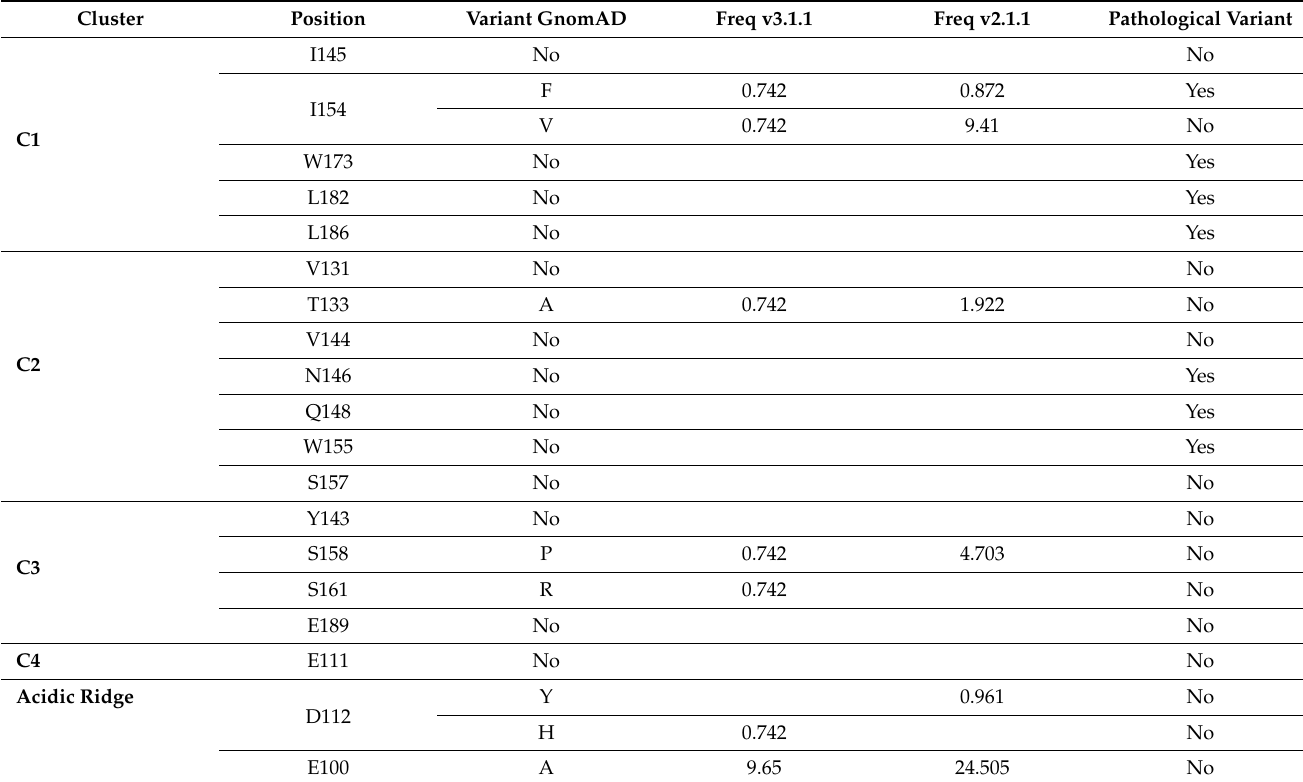
Table 2. Variants and its frequency observed in the indicated GnomAD non-neuro databases in amino acids from cluster 1 to 4 and from the acidic ridge. Frequency is indicated in × 10 5 . Variant observed is indicated in one-letter amino acid code.